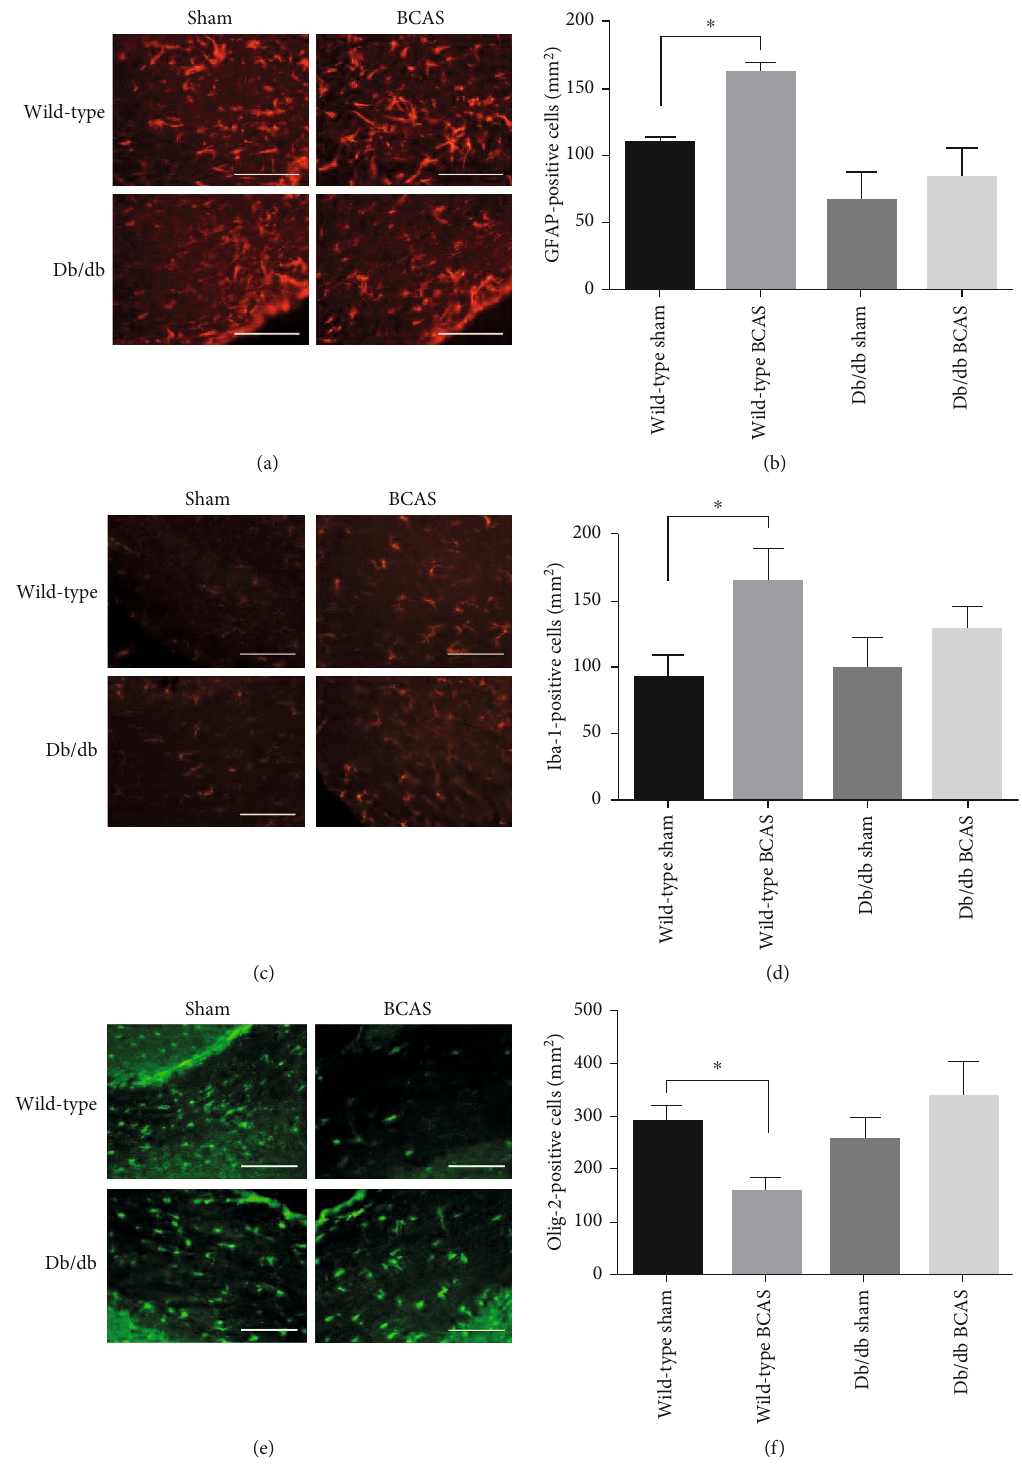
Figure 4: Immuno fl uorescence staining of glial cells in the corpus callosum of wild-type and db/db mice with sham or BCAS operation for four weeks. (a) Representative images of GFAP-positive astrocytes. (b) Histogram of GFAP-positive astrocytes density in di ff erent groups. (c) Representative images of Iba-1-positive microglia. (d) Histogram of Iba-1-positive microglia density in di ff erent groups. (e) Representative images of Olig-2-positive oligodendrocytes. (f) Histogram of Olig-2-positive oligodendrocytes density in di ff erent groups. N = 3 − 5 , scale bar = 100 μ m , and ∗ p < 0 : 05